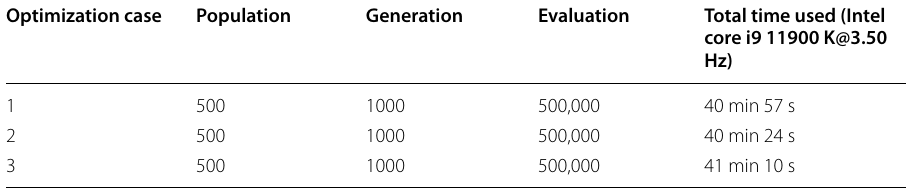
Table 13 GA parameters and time cost for the three optimization cases Optimization